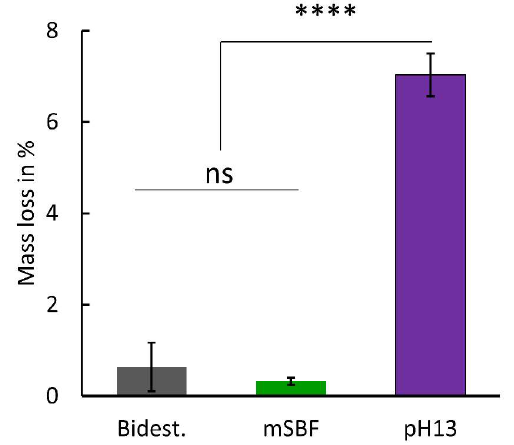
Figure 8. Mass loss of the PCL fibers after immersion in dist. water, mSBF, and NaOH solution (pH